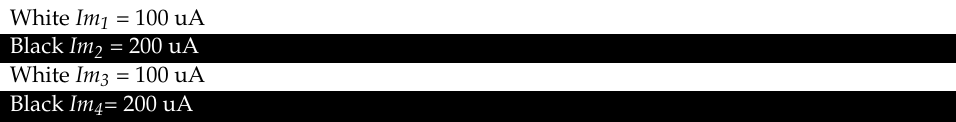
Table 2. The example of pattern with four pixels.